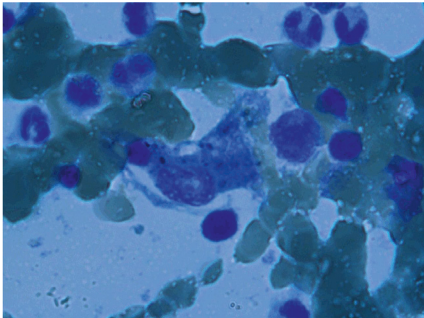
Figure 1: Bone marrow aspiration for case one showing macro- phage activation syndrome (MAS).